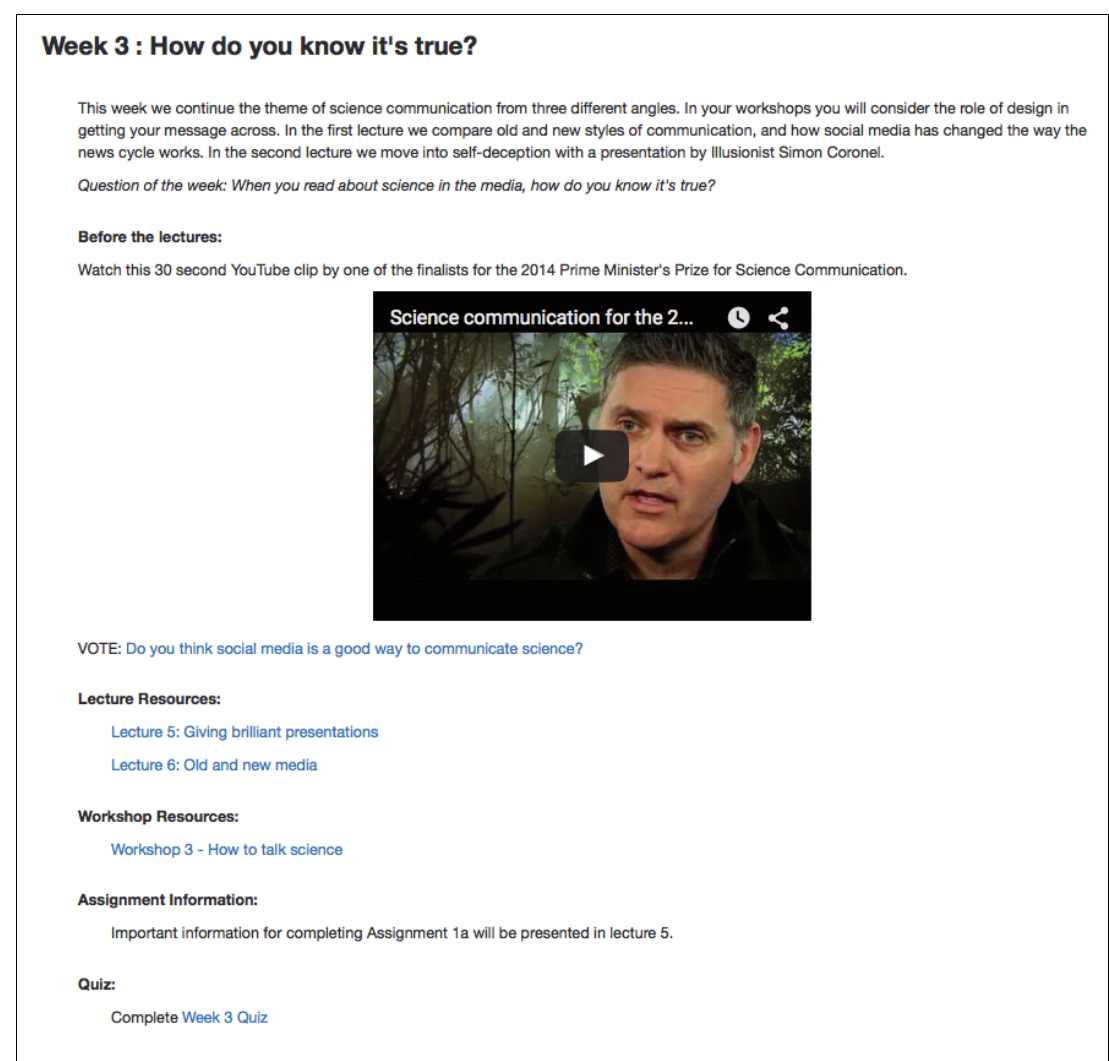
Figure 4. Science communication for the 21st Century. Question of the week - a Moodle polling activity. Students view a short video or image and are asked to participate in a poll. Video: Science communication for the 21st Century.